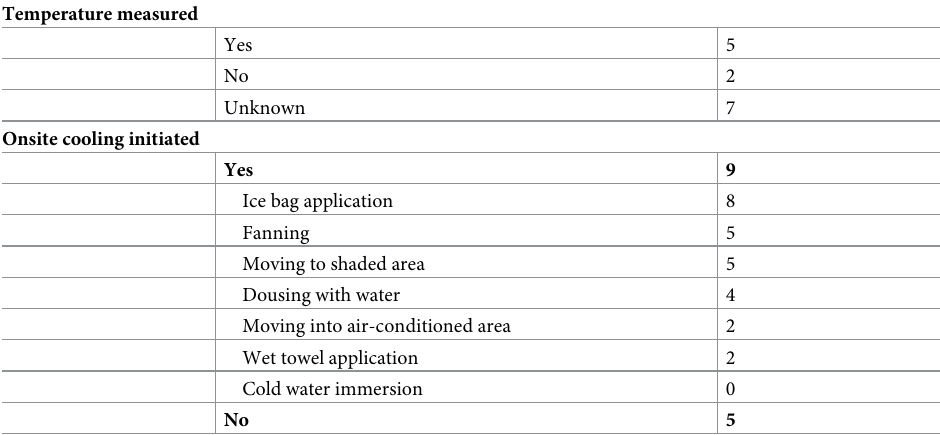
Table 2. Temperature assessment and immediate onsite care for 14 fatal EHS (exertional heat stroke) reported to Japan Sports Council that happened during high school organized sports in Japan between 2009 and